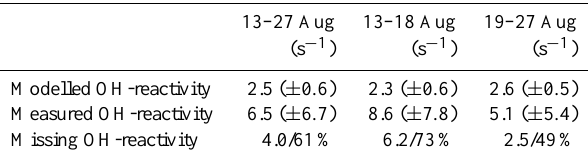
Table 1. Modelled, measured and missing OH-reactivity for 13 to 27 August 2008 given as mean. Standard deviations are given in